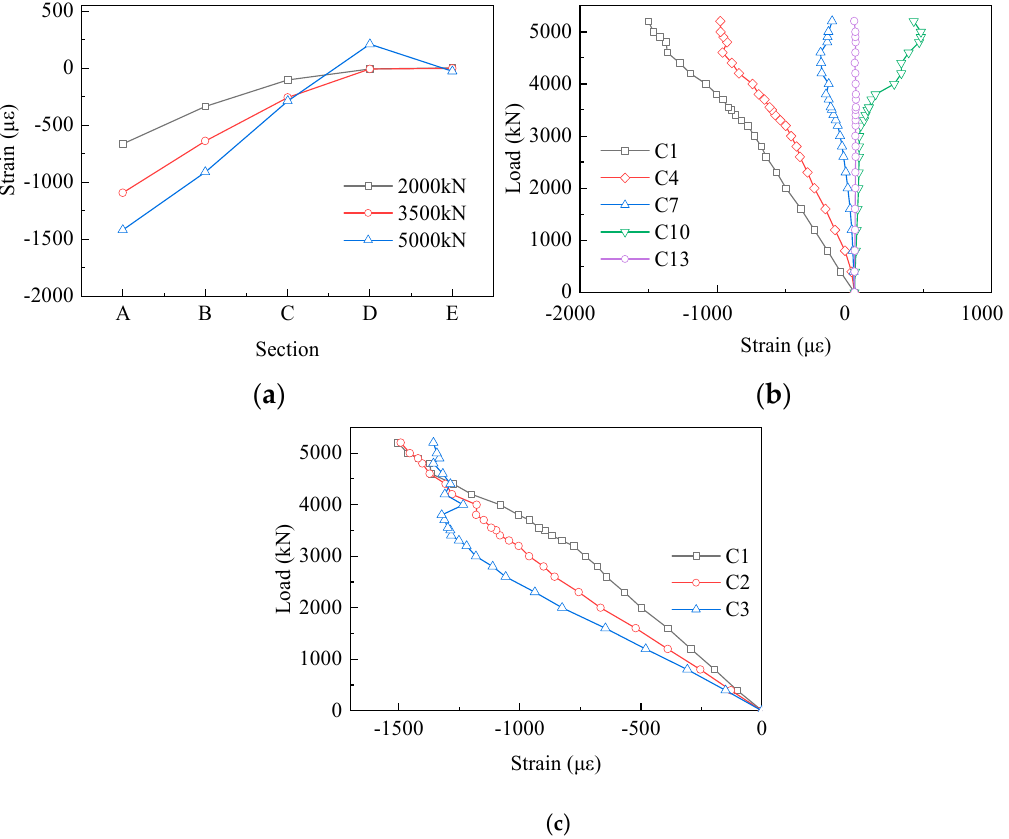
Figure 8. Strain results of the concrete chord: ( a ) the average strain values of each section; ( b ) the first row of the strain gauges; ( c ) the first column of the strain gauges.